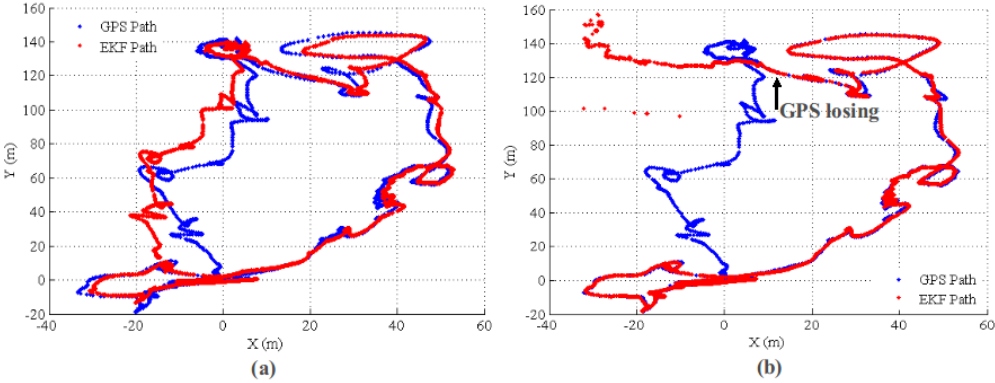
Figure 20. EKF state estimation without VO update for GPS outage from 500 s to the end. Both of the error and error covariance are sharply increased, and state estimation becomes unusable. ( a – c ) The results for X , Y and Z , respectively. The blue line is the position error, and the red line is the 3 σ error band from the state covariance.